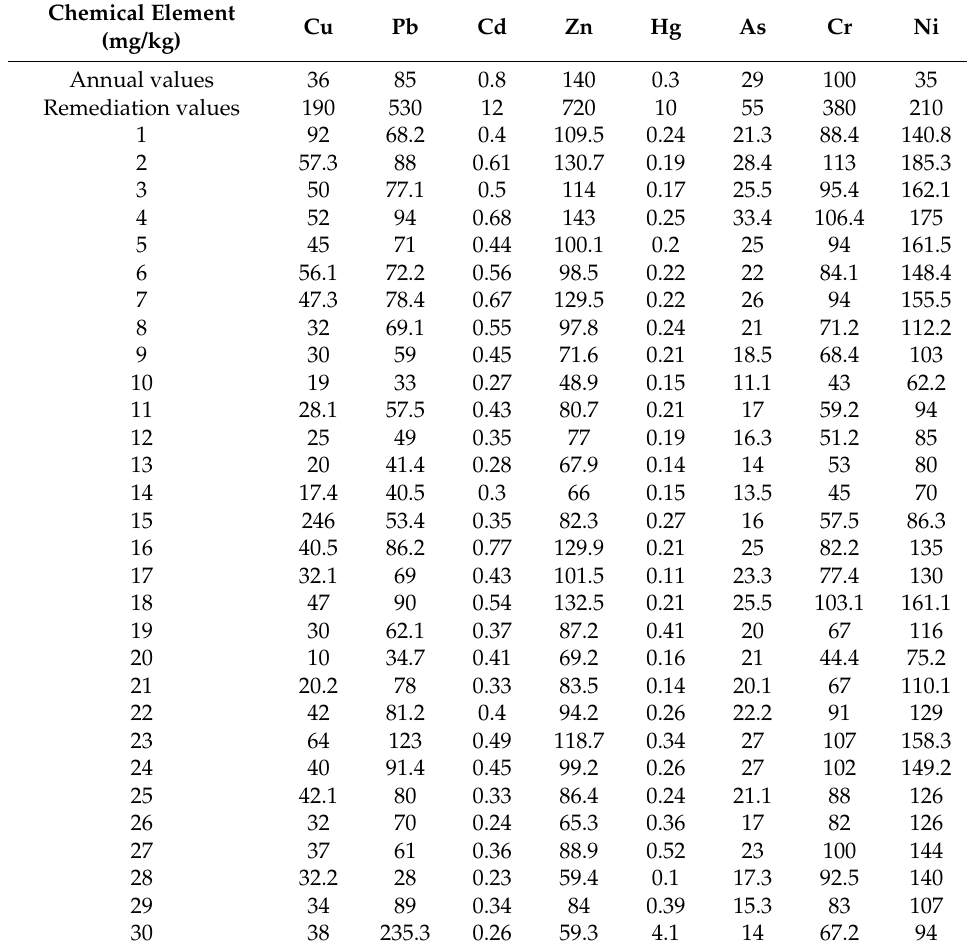
Table 2. Results of chemical analyses of heavy metal content in soil samples collected in the surroundings of Kostolac coal basin.